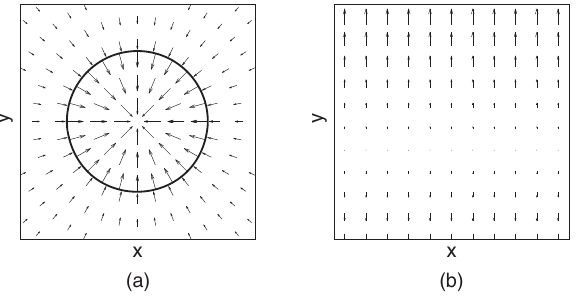
FIG. 2. Field vector plots that were shown to students during the interview: (a) the electric field corresponding to the charged cylinder of question 2(a); (b) a field used to explain to students how they can decide whether the divergence is zero or not at a certain location.